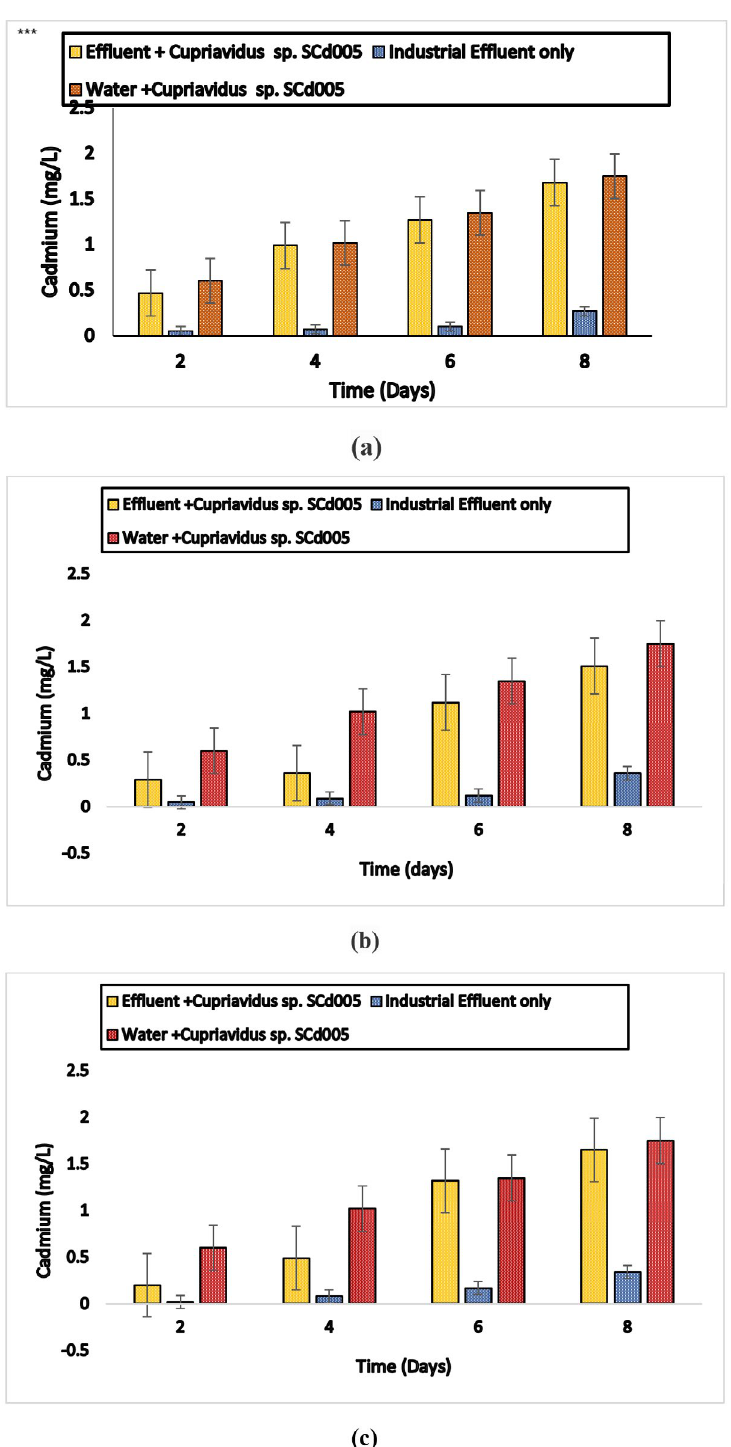
Fig. 6. Biosorption of Cadmium by a) Cupriavidus sp. SCd005 (Electroplating) b) Cupriavidus sp. SCd005 (Battery) c) Cuprividus sp. SCd005